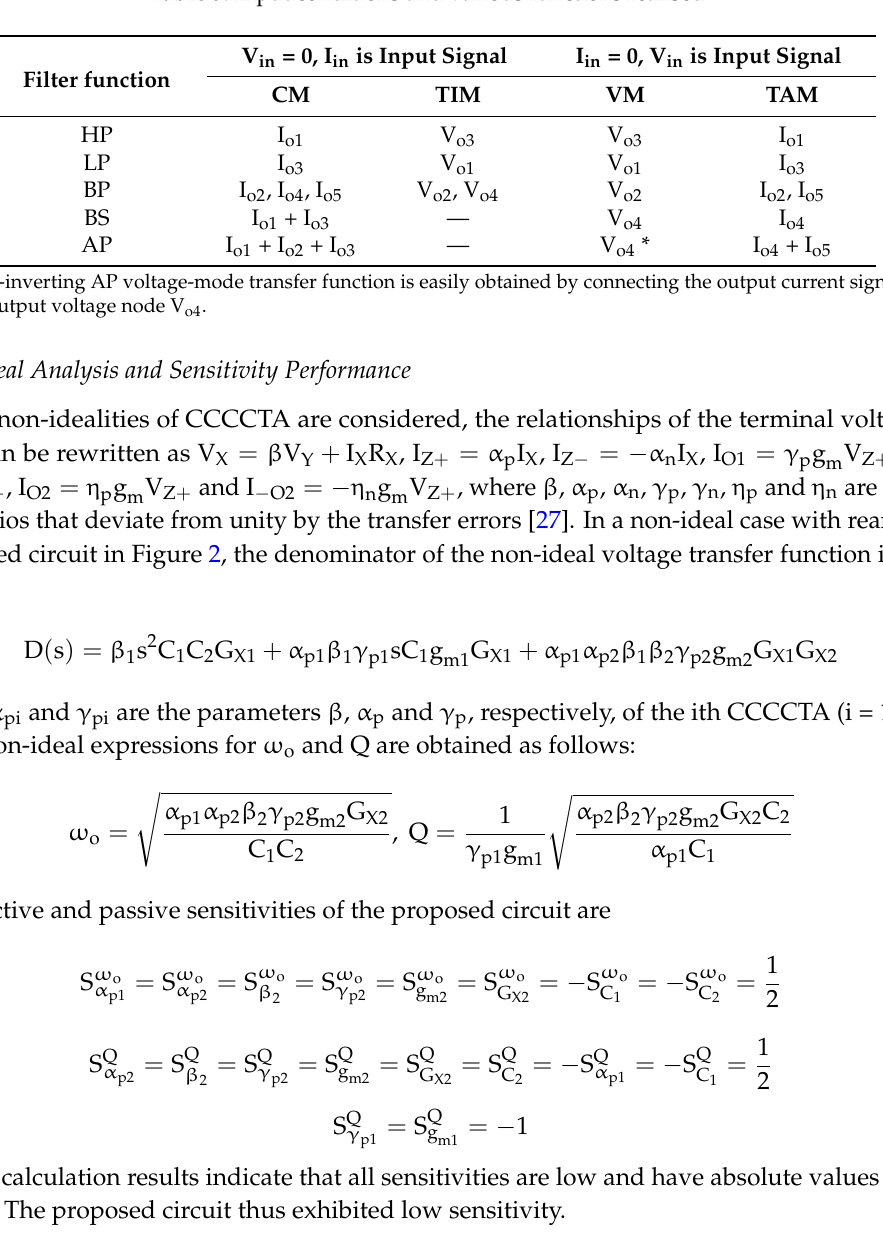
Table 5. Input conditions and various functions